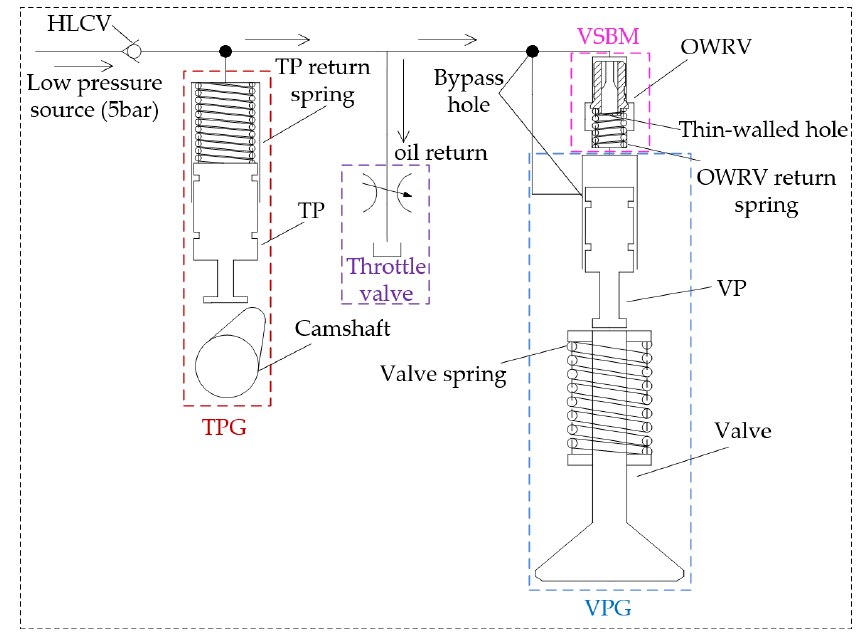
Figure 1. The working principle of